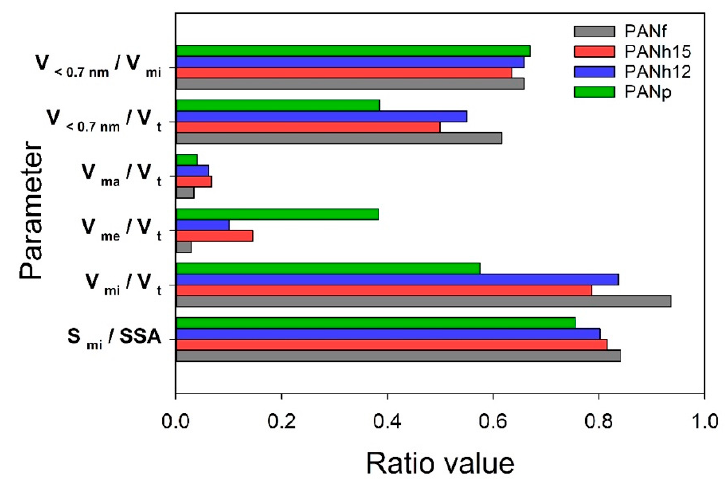
Figure 4. The ratios of surface areas and pore volumes obtained from N 2 adsorption–desorption data at − 196 °C for all samples.